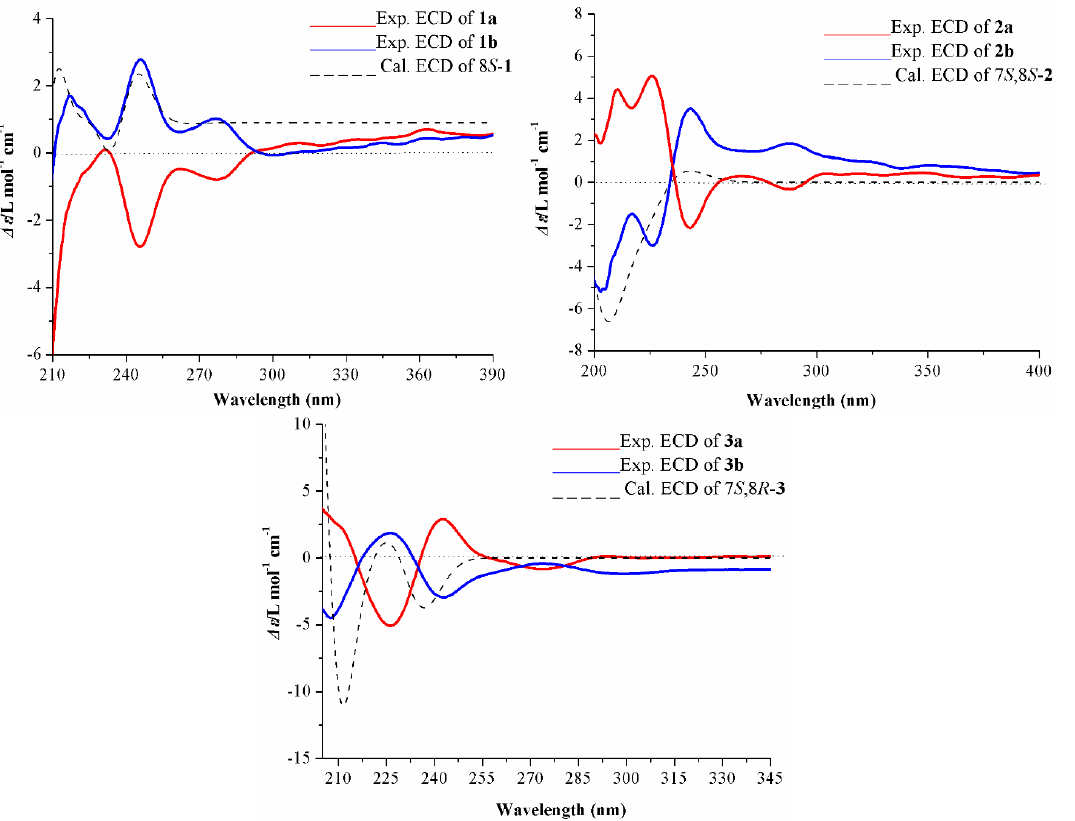
Figure 3. Experimental and calculated ECD spectra of compounds 1 – 3 .